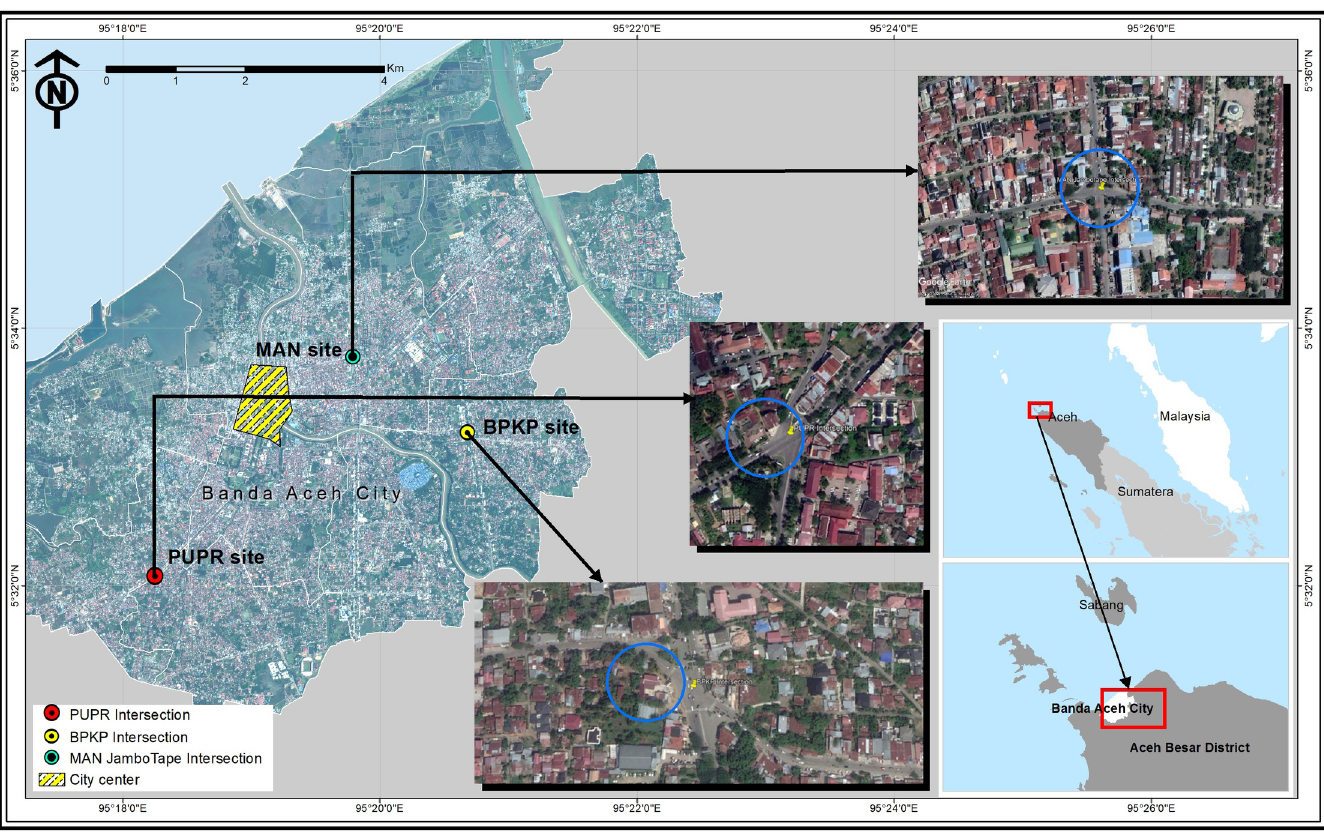
Fig 1. Map of study area (within city center of Banda Aceh, Aceh